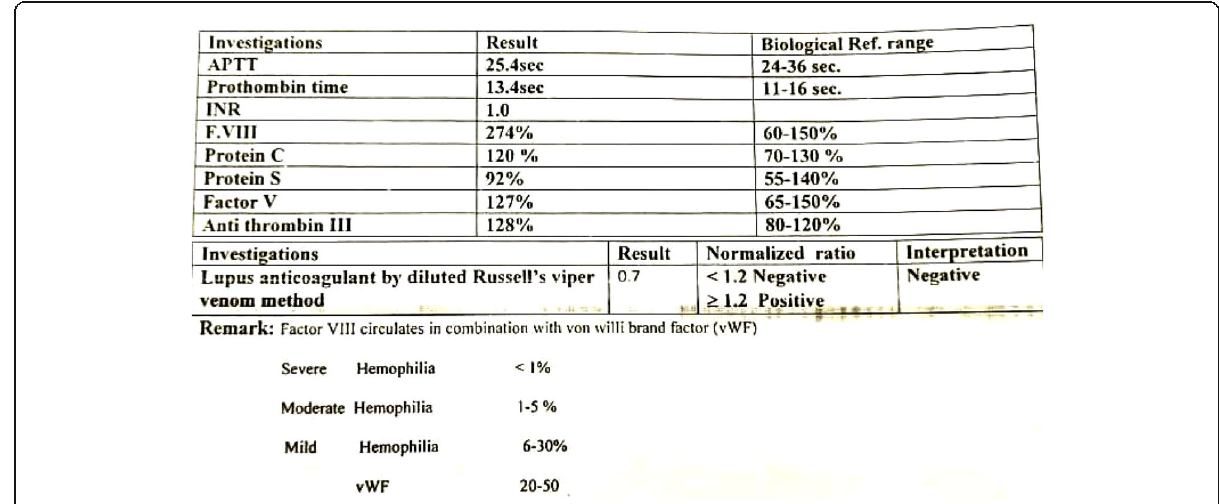
Fig. 3 The coagulation profile at 6 months post